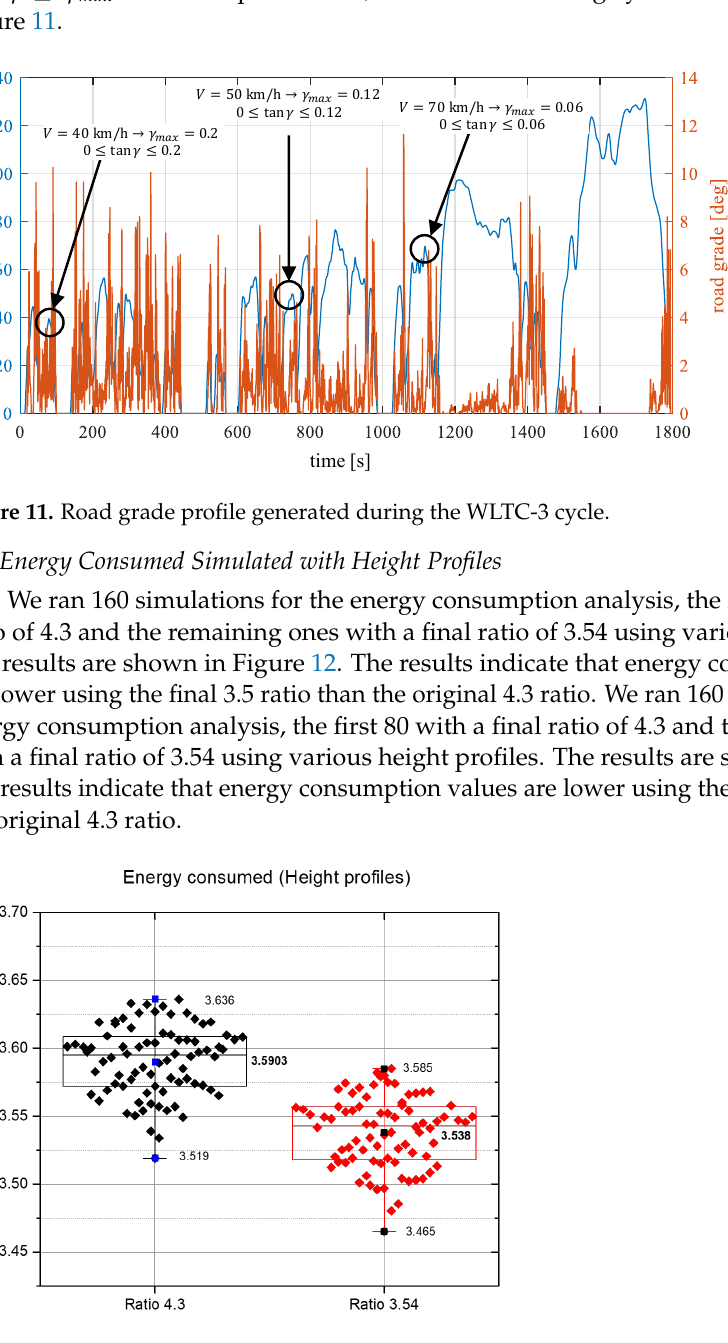
Figure 12. Energy consumed simulated with height